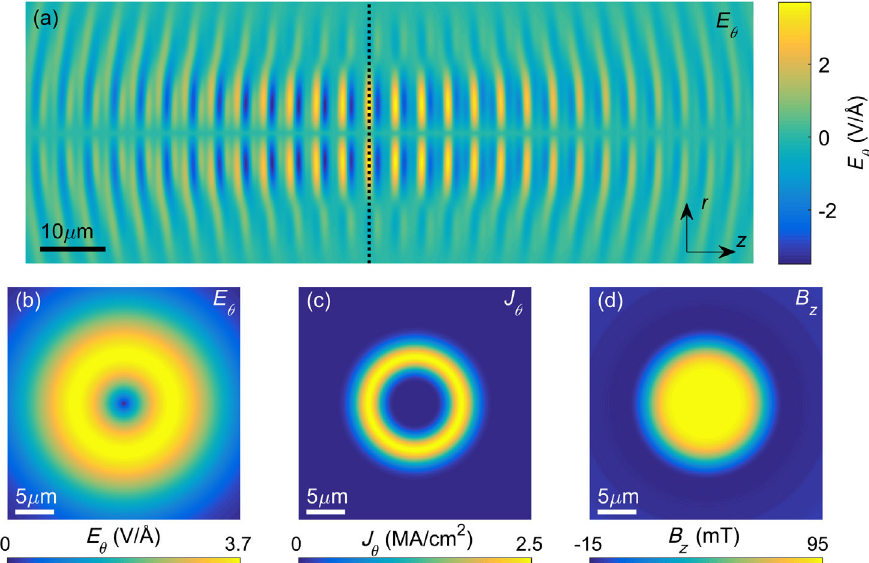
FIG. 1. Numerical simulations of strong field coherent control in atomic hydrogen using azimuthal vector beams. (a) A snapshot of the electric field from an azimuthal vector beam propagating through a Gaussian focusing geometry with beam waist, w 0 ¼ 6 μ m. (b) A transverse slice of the azimuthal electric field mode at the beam waist. (c) A transverse slice of the azimuthal current density at the beam waist. (d) A transverse slice of the longitudinal magnetic field produced by the current density at the beam